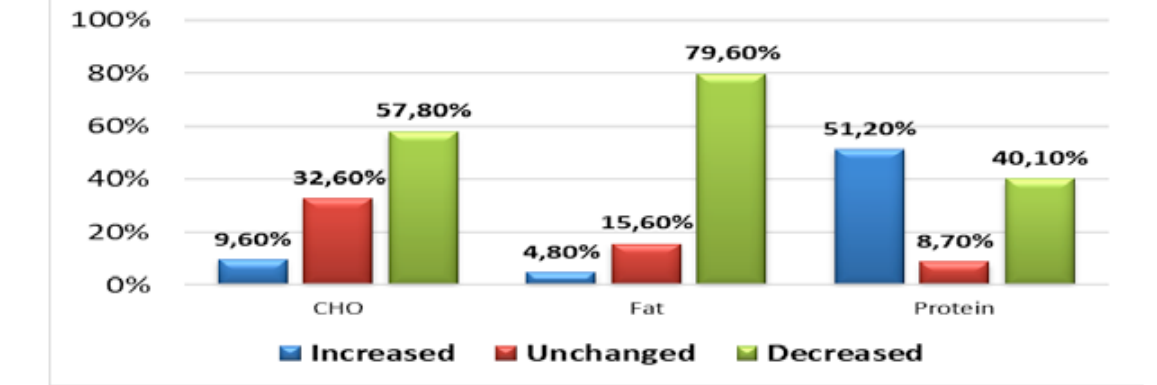
Figure 1. Athletes’ macronutrient intake ratio for COVID-19